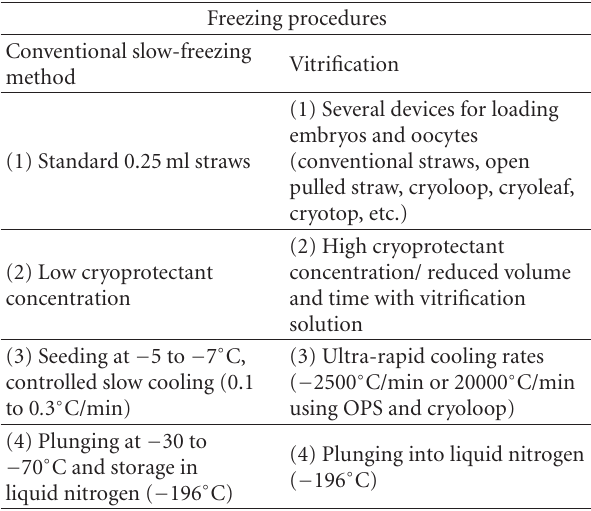
Table 2: Comparison of oocyte and embryo cryopreservation